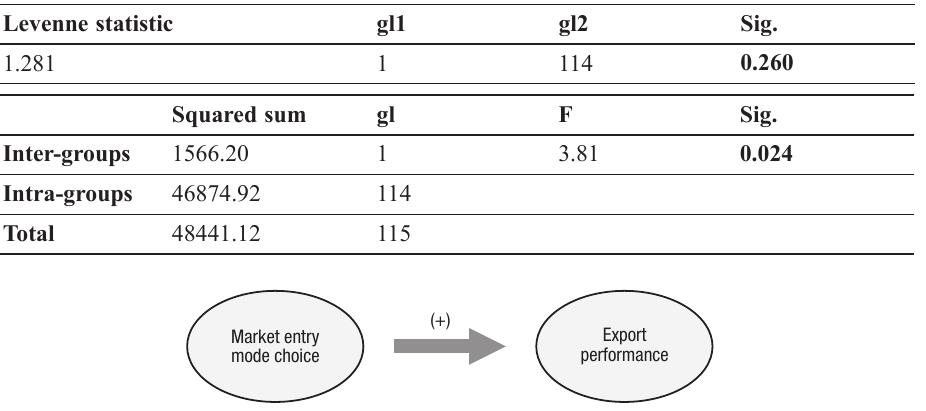
Table 3. Homogeneity test of variances (entry mode – export performance)